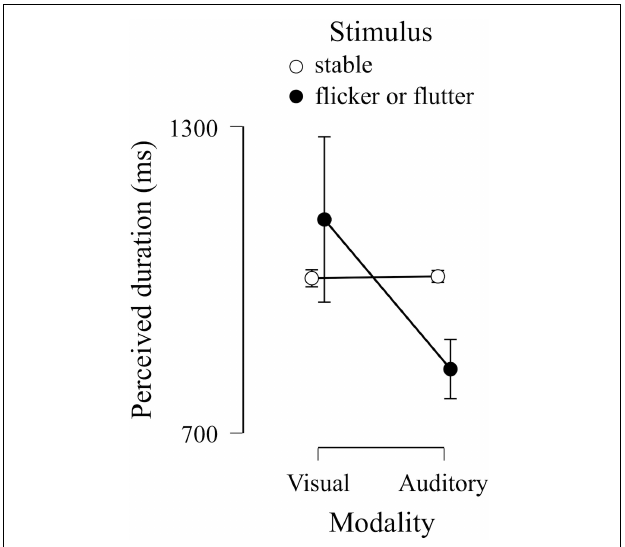
FIGURE 6 | Group results of points of subjective equivalence (PSEs) in unimodal session. The dots indicate the means of PSEs in each condition. Error bars indicate a 95% credible